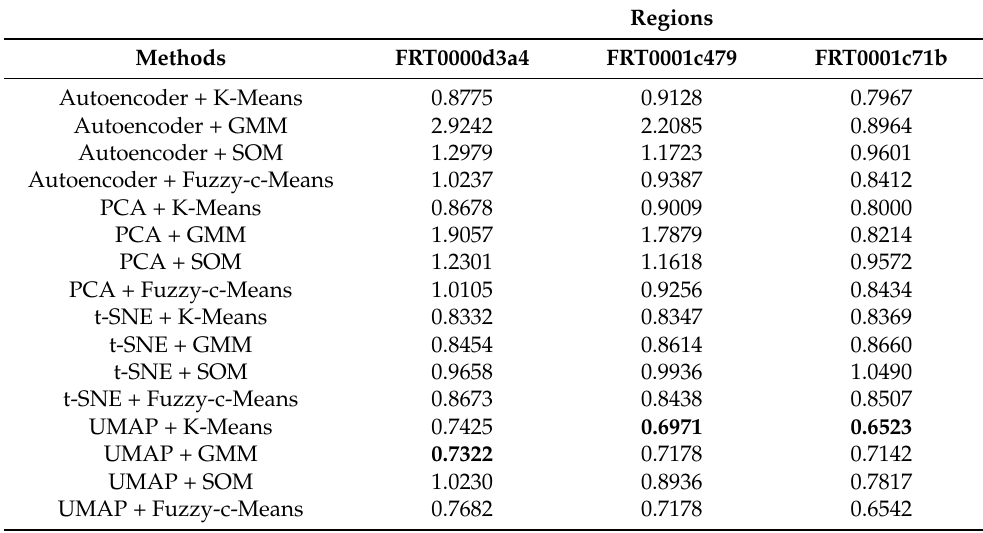
Table A1. Mean of the Davies–Bouldin criterion over a range of three to seven clusters, split by method and region. The best score for each dataset is in